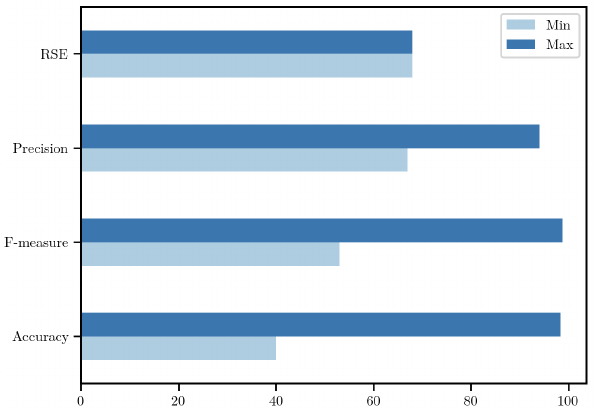
Figure 6. Percentage of models used for ruling decision prediction.